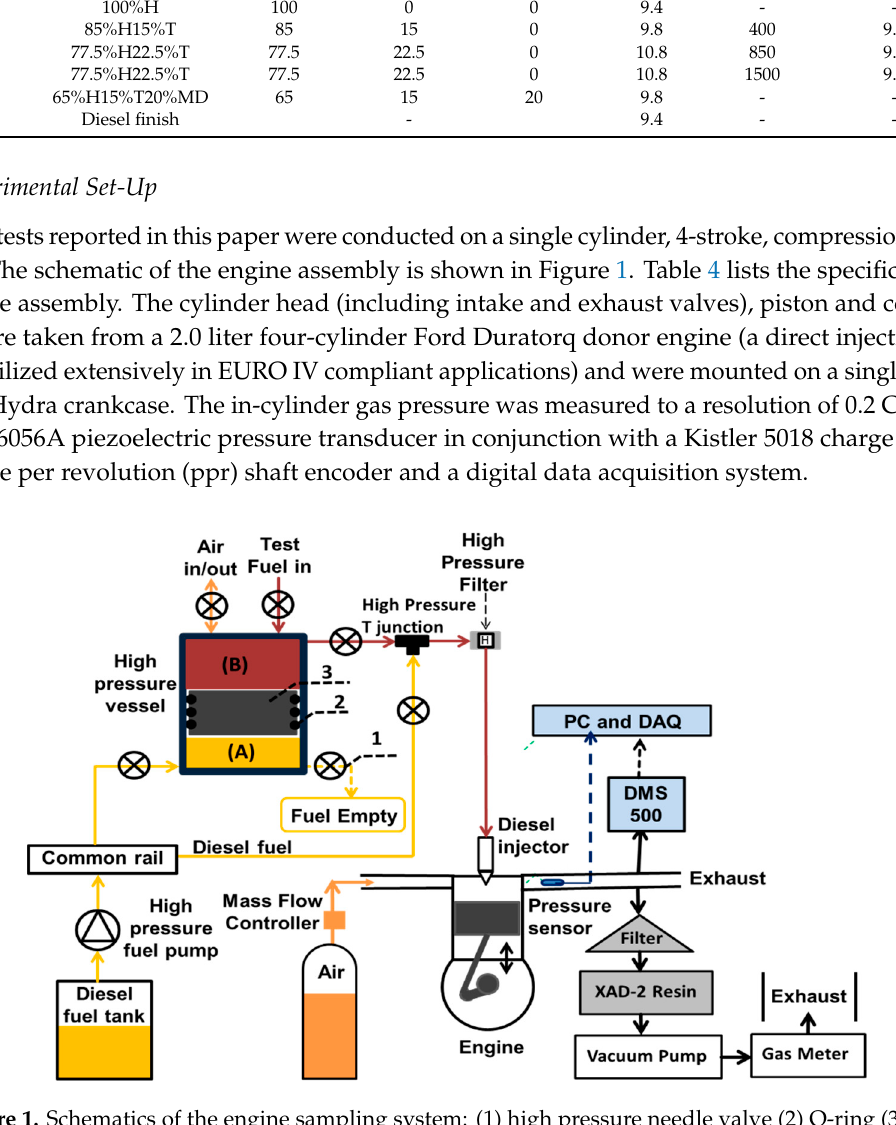
Figure 1. Schematics of the engine sampling system: (1) high pressure needle valve (2) O-ring (3) free moving piston. Table 4. Engine specification.